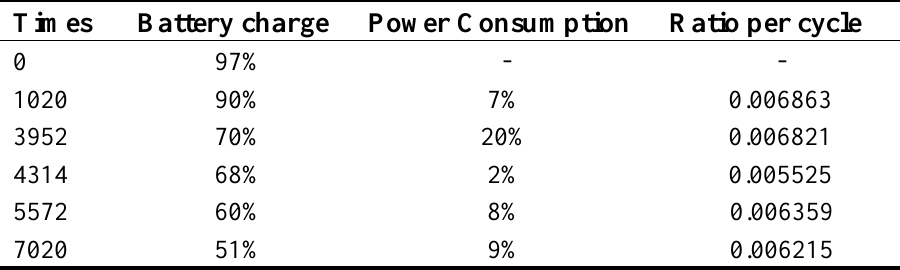
Table 5. Power consumption per awake